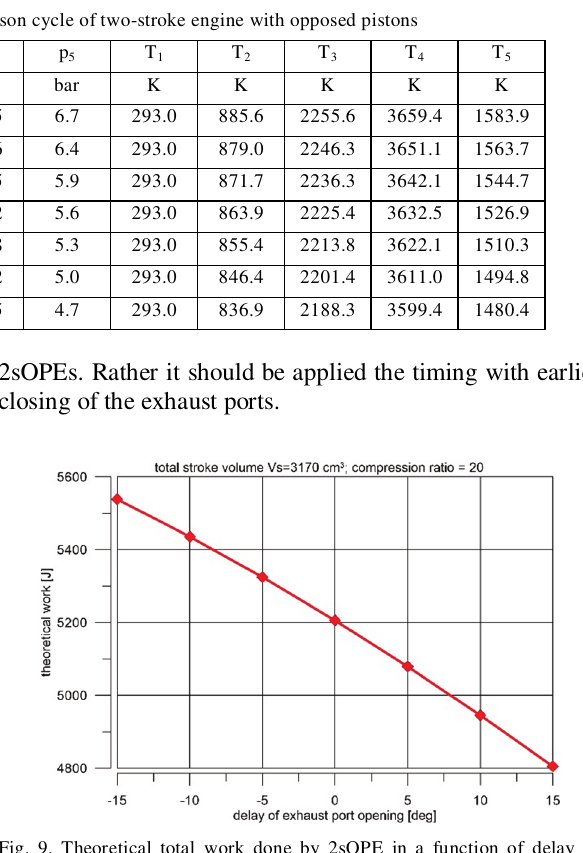
Fig. 9. Theoretical total work done by 2sOPE in a function of delay of opening of exhaust ports